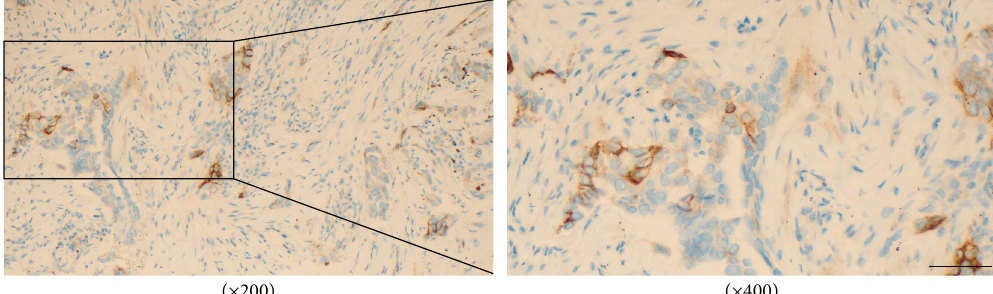
Figure 3: Positive PD-L1 in GC cells and staining was located in the cell membrane or cytoplasm, showing brown-yellow particles, scale bar: 20 μ m. Table 2: Comparability of CD4 + T, CD8 + T, Foxp3 + T cell count between carcinoma and normal adjacent tissues.